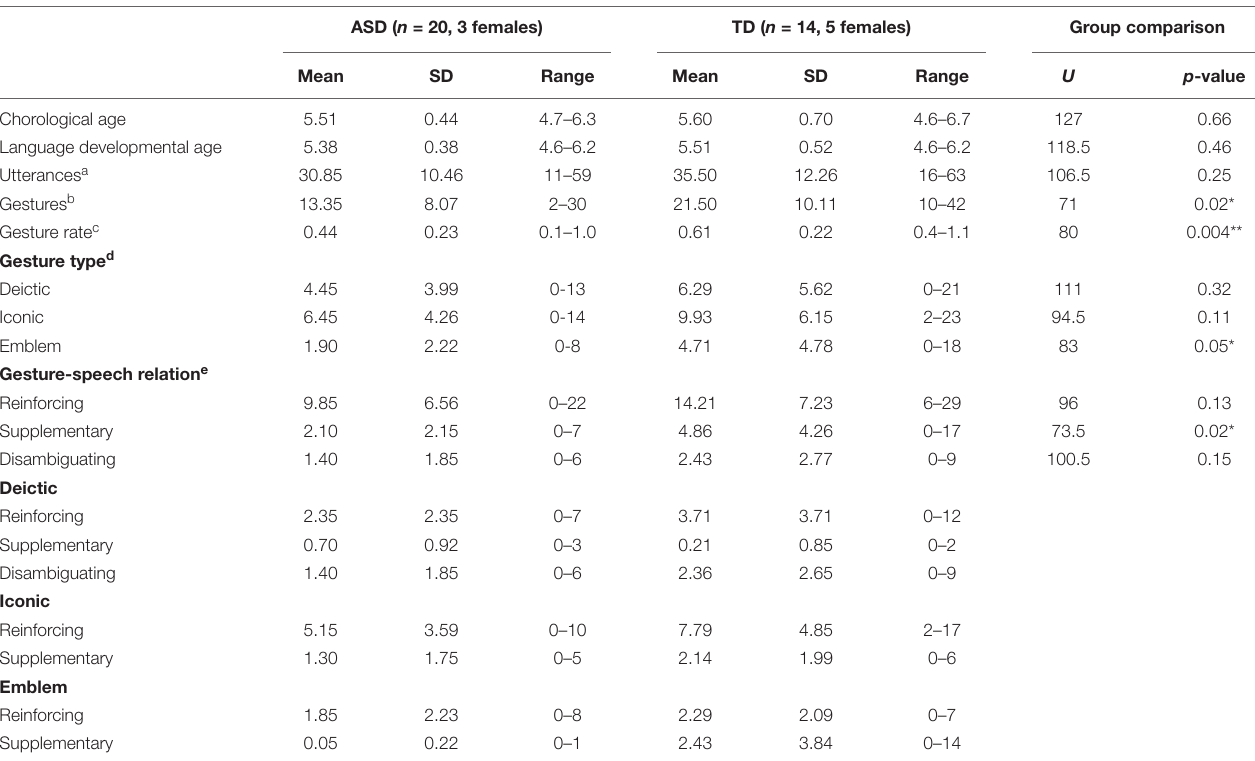
TABLE 3 | Participants’ characteristics, gestural skills, and comparison between the ASD and TD group. ASD ( n = 20, 3 females) TD ( n = 14, 5